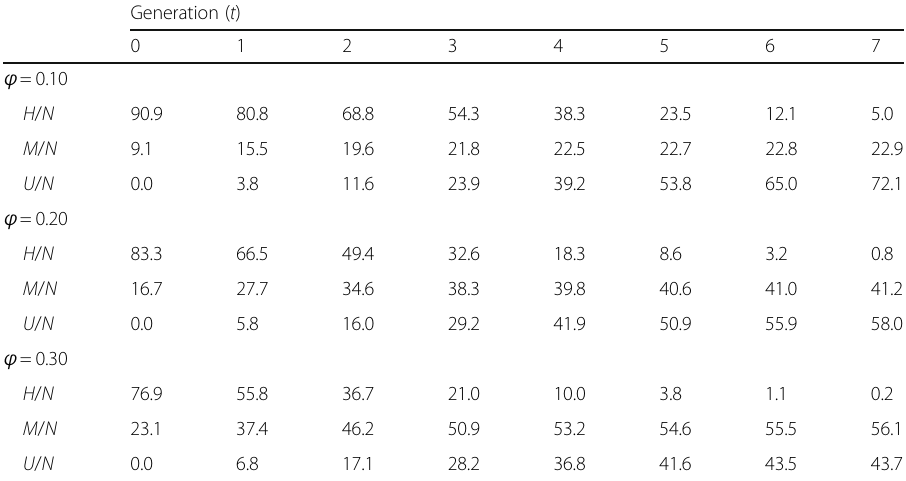
Table 6 Component populations as percent of total: indifference preference pattern with repeated immigration ( ϕ = 0.10, 0.20,